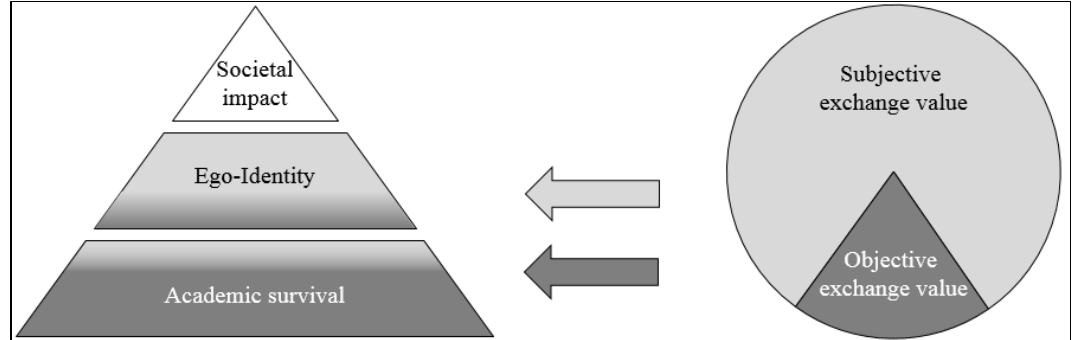
Figure 6. How the subjective and objective value satisfy scientists’ needs. Source: own illustration. Please note that the fraction of the subjective versus objective value does not indicate a specific ratio.